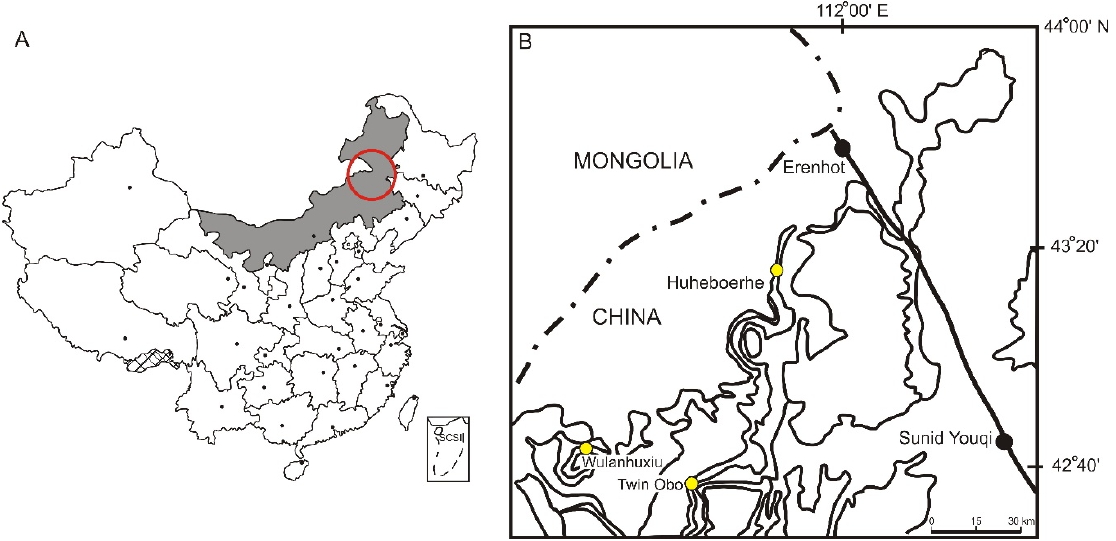
Figure 1. Anagalid-bearing localities in Nei Mongol (gray area), China. ( A ). Schematic map of China with the approximate location of the Erlian Basin marked by red circle. ( B ). Localities in the vicinity of Erenhot, which yielded anagalid remains (yellow dots). (( B ), after Fostowicz-Frelik et al. [24], modified).